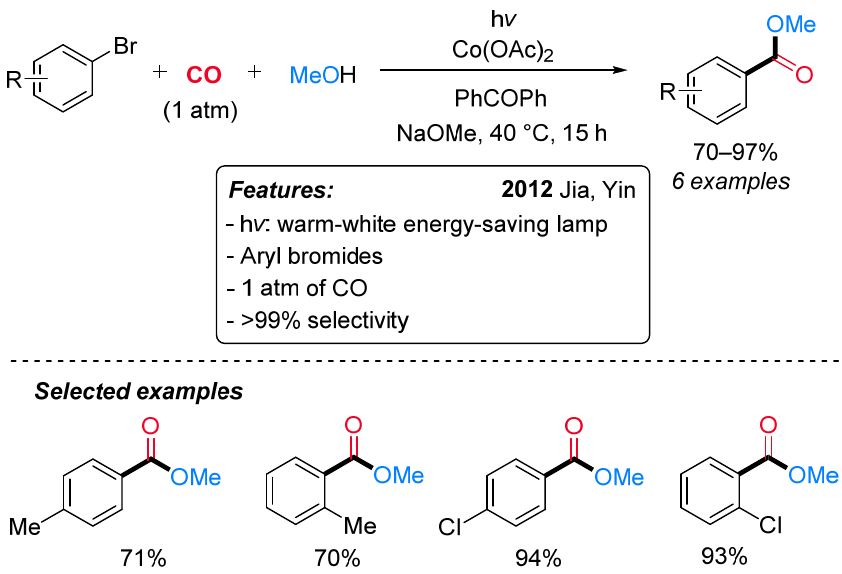
Scheme 30. Visible-light-mediated cobalt-catalyzed alkoxycarbonylation of aryl bromides.